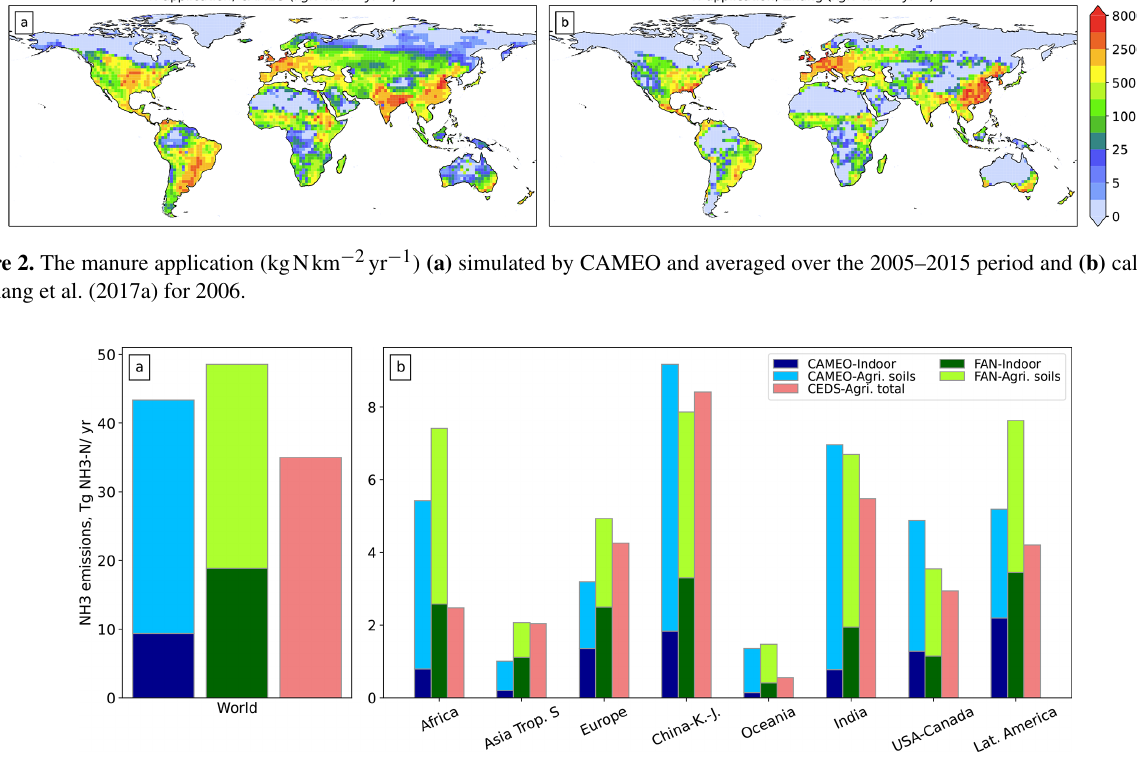
Figure 3. Averaged global (a) and regional (b) NH 3 emissions (TgNyr − 1 ) from indoor activities (“Indoor”, darker bars) and agricultural soil (“Agri. soils”, lighter bars) computed by CAMEO over the 2005–2015 period (“CAMEO”, blue bars) and FANv2 (Vira et al., 2020) over the 2010–2015 period (“FAN”, green bars). Total agricultural emissions (accounting for manure management and soil volatilization) estimated in the CEDS inventory (2005–2014 average) (McDuffie et al., 2020) are represented in purple (“CEDS-Agri. total”). China–K–J accounts for China, Korea, and